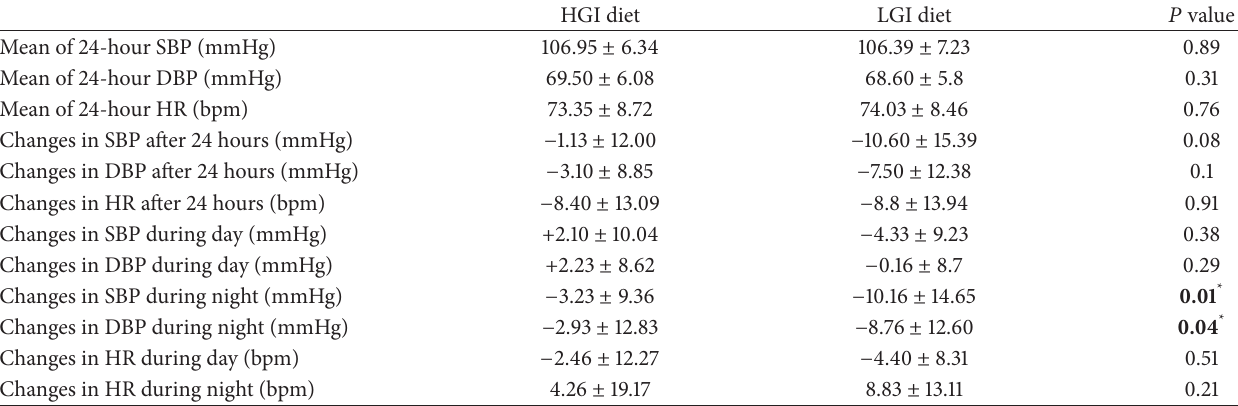
Table 6: The comparison between percent changes of blood pressure in LGI foods and HGI